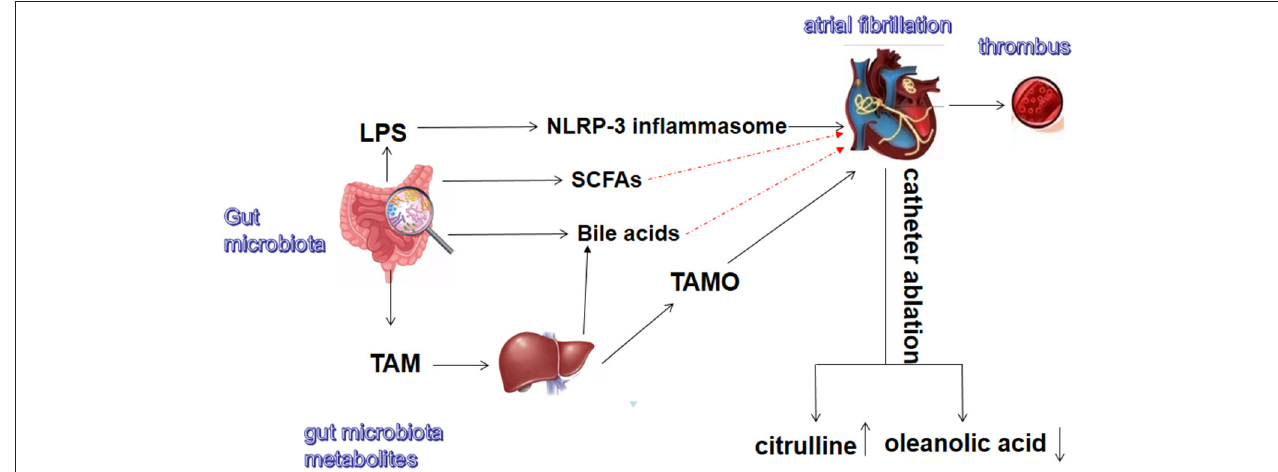
FIGURE 1 | Gut microbiota and metabolites related to atrial fibrillation. TMA, trimethylamine; TMAO, trimethylamine N-oxide; LPS, lipopolysaccharide; SCFAs, short-chain fatty acids. The red dash lines indicate these metabolites might exert protective effect on atrial fibrillation.